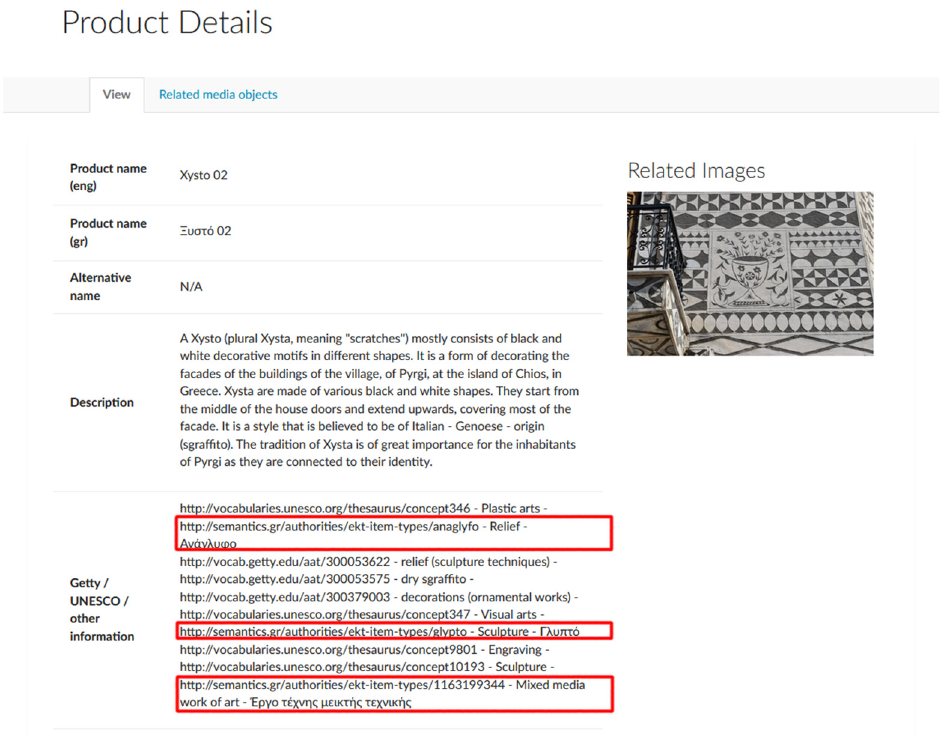
Figure 5. A knowledge element annotated using international and national controlled vocabularies.